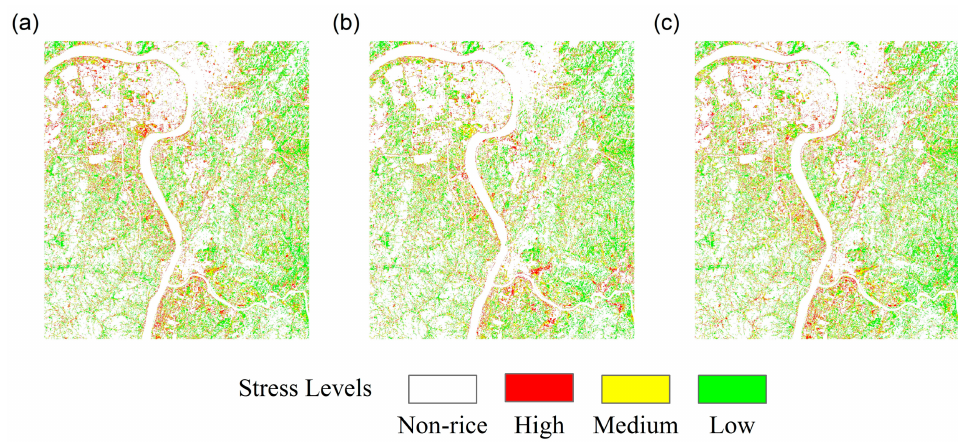
Figure 6. Spatial distributions of stress levels using the multitemporal monitoring model. ( a ) Booting stage; ( b ) flowering stage; ( c ) mature stage.